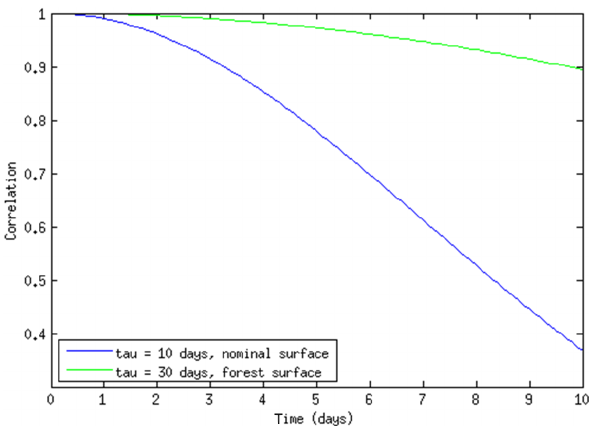
Figure 3. Autocorrelation functions for vegetation optical depth (VOD) for different correlation lengths (green shows forested sur- faces and blue shows nominal